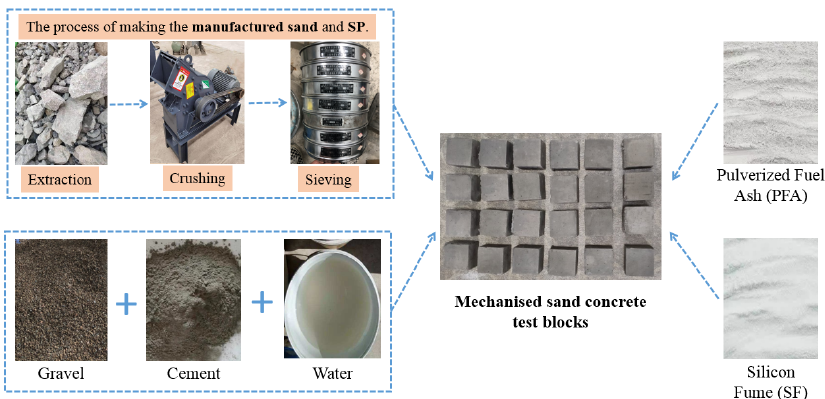
Figure 3. Concrete block-making process.